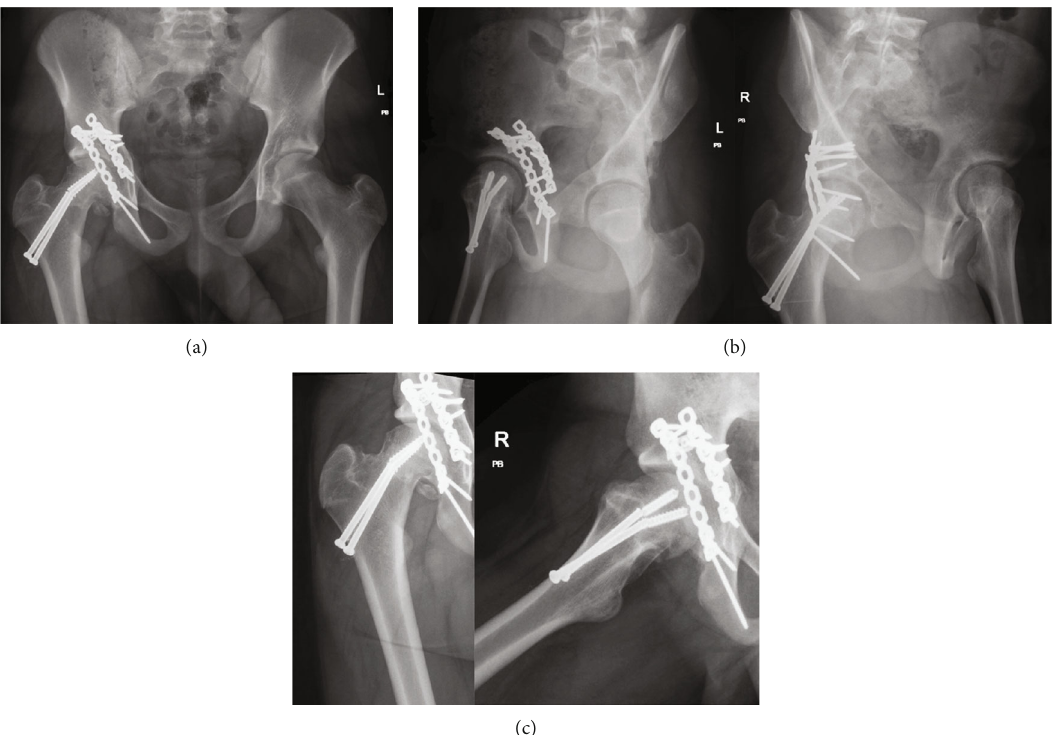
Figure 6: (a) AP and (b) Judet pelvis radiographs and (c) AP and lateral right hip radiographs taken 22 months after the fi xation demonstrating interval healing of the right acetabulum and proximal femur, maintenance of joint space and concentricity, and no evidence of avascular necrosis. The two femoral neck screws have been broken since prior radiographic evaluation, and there is a varus malunion of the right proximal femoral physeal separation.